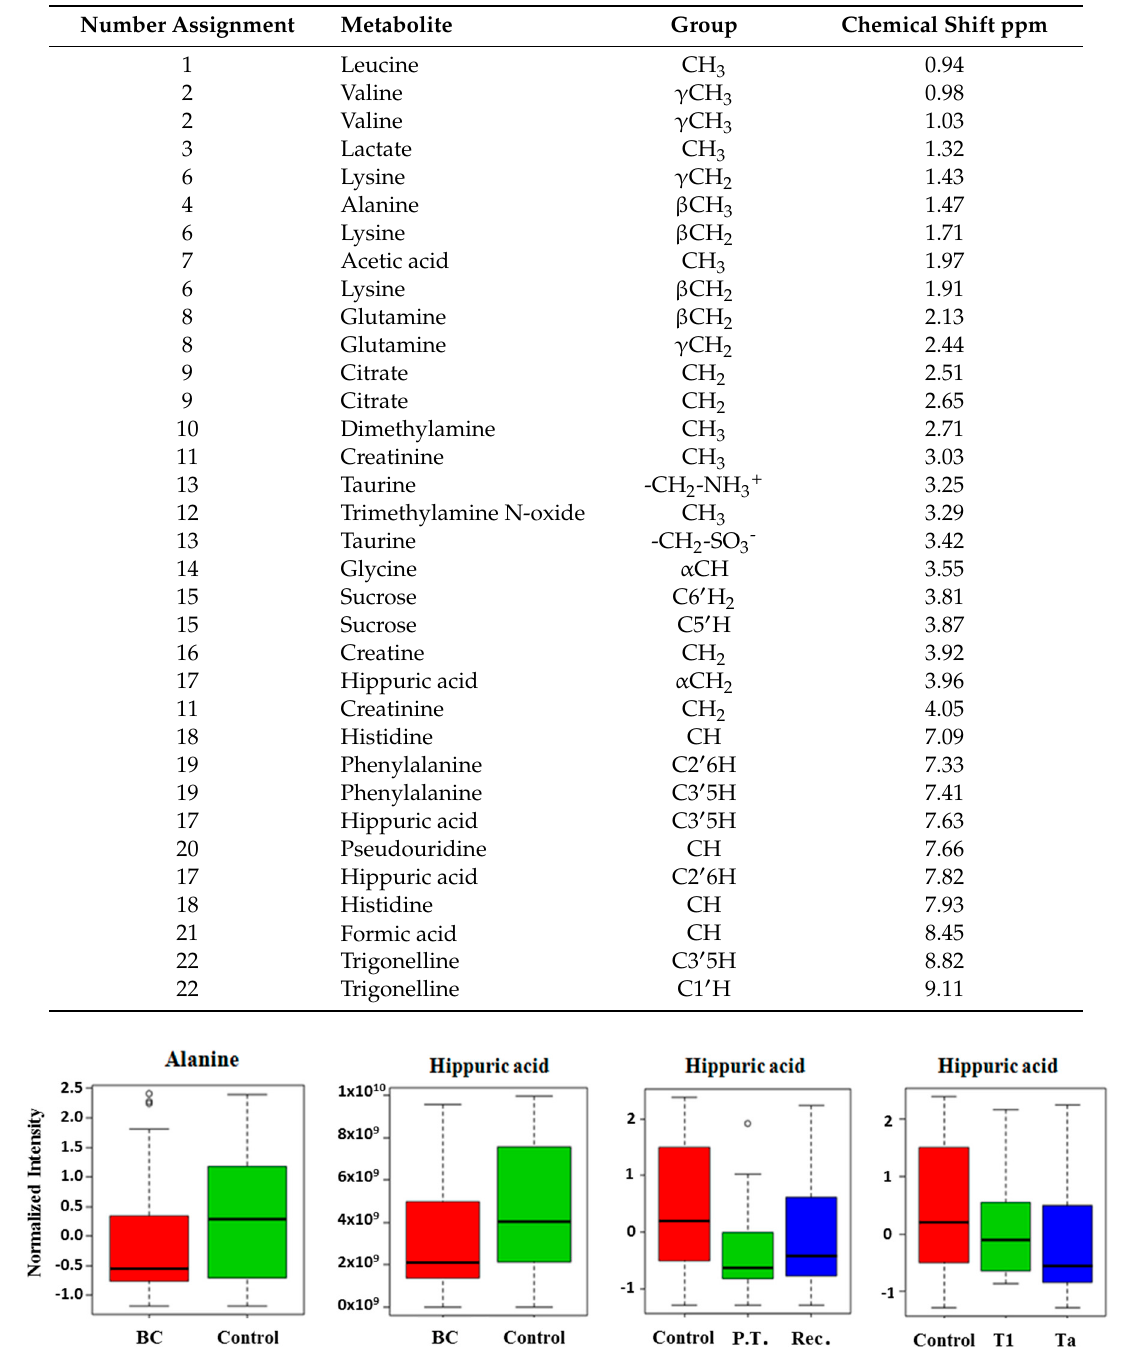
Figure 2. Box and whisker plots illustrating discrimination between: bladder cancer (BC) and control urines; control, primary tumor (P.T), and recurrences (Rec.); and differences among stages (Ta and T1) of BC and control